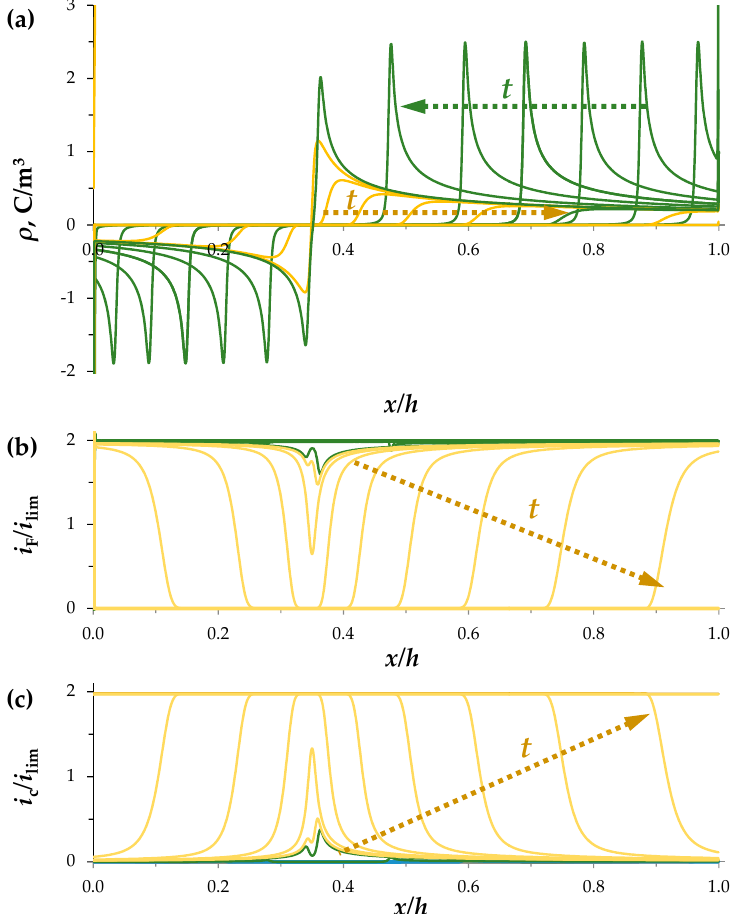
Figure 3. Distribution of the space charge density, ρ , ( a ), normalized conduction current density, i F /i lim , ( b ) and charging current density, i C /i lim , ( c ) at t = 0, 4, …, 24, 25.65 s (green lines) and during the discharge process t = 25.66, 25.67, …, 25.75 s (yellow lines) for the perfectly selective membranes, T 2C = T 1A = 0, i = 2 i lim .